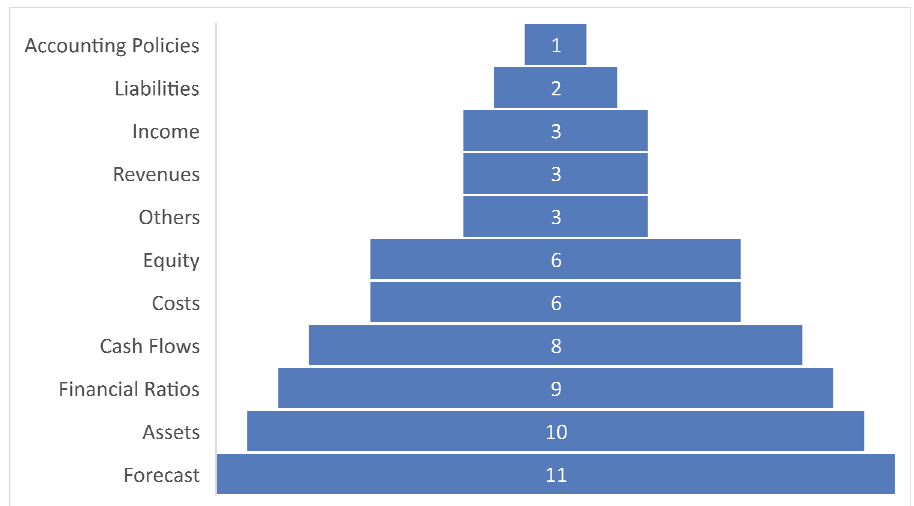
Fig. 2. The ranking of disclosure level of listed companies in